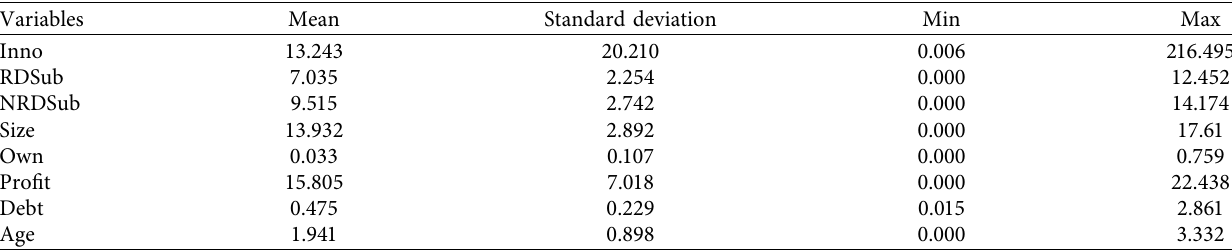
Table 2: Descriptive statistics.